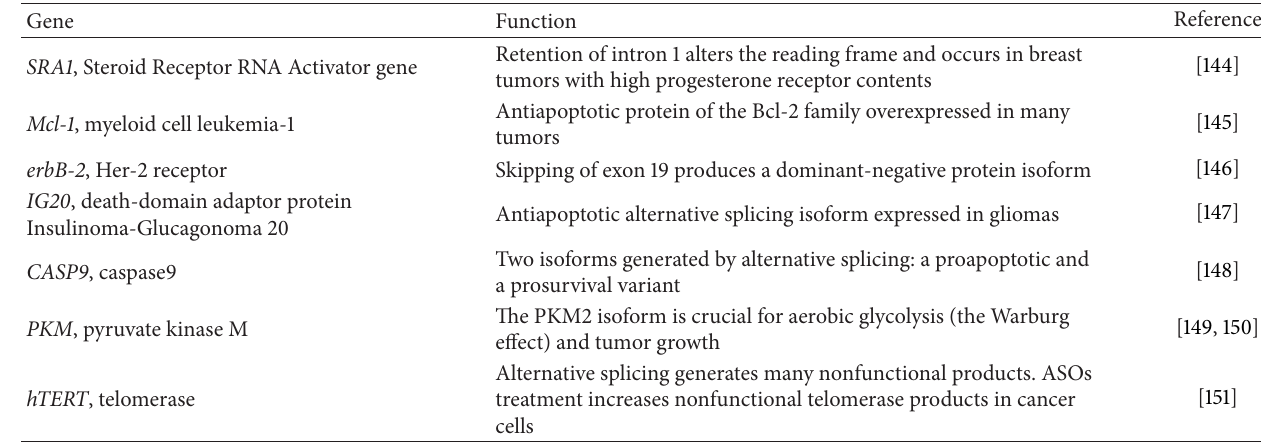
Table 2: Examples of ASO treatments in cancer cell